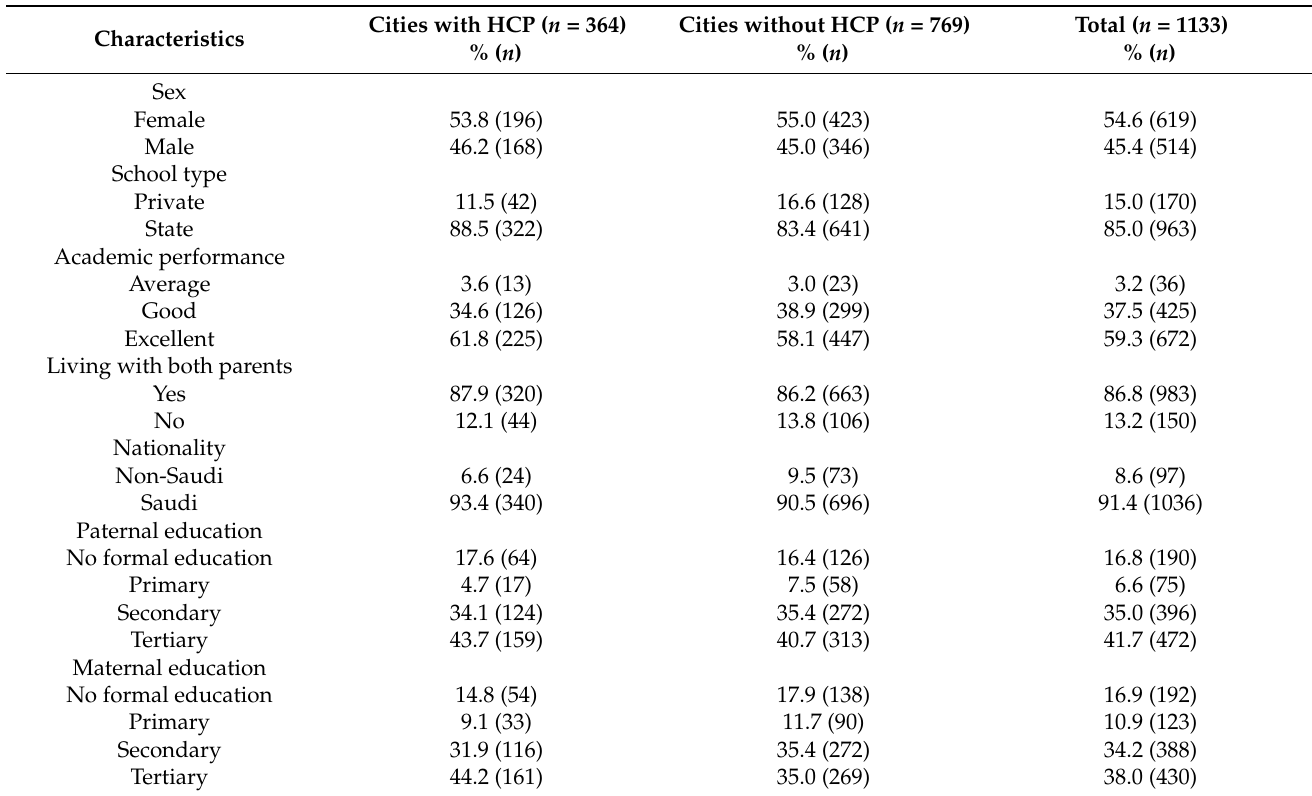
Table 1. Socio-demographic characteristics of the adolescents.